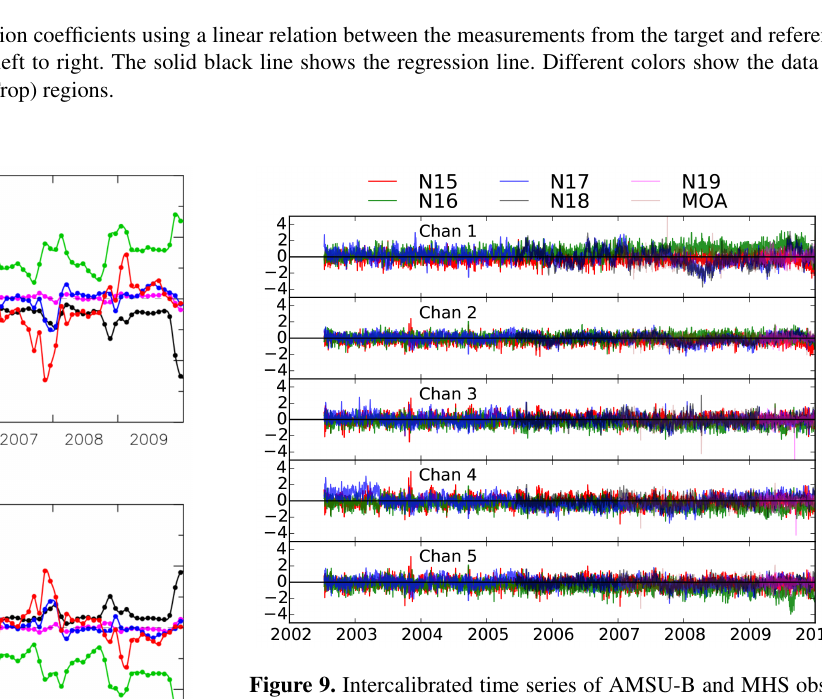
Figure 9. Intercalibrated time series of AMSU-B and MHS obser- vations. NOAA-19 and MetOp-A (MOA) are intercalibrated with reference to MHS on board